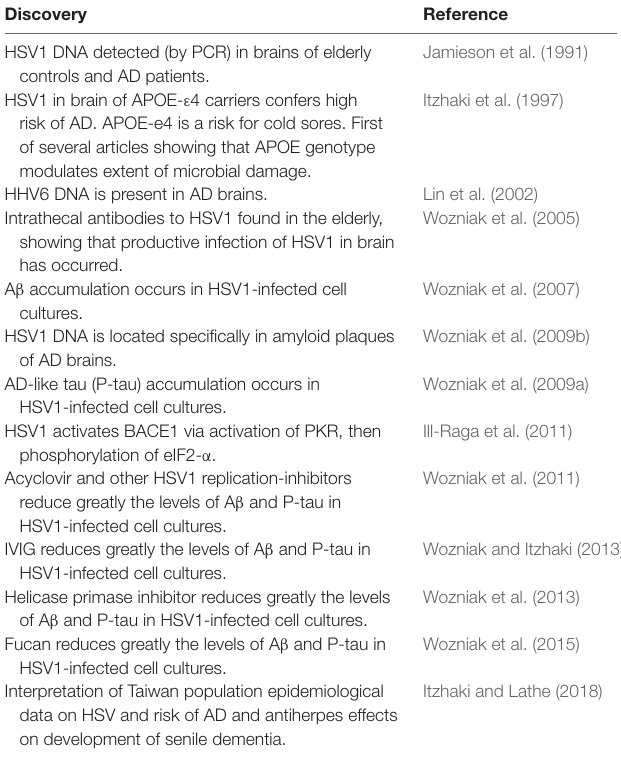
TABLE 1 | Main data on herpes simplex virus type 1 (HSV1) and AD from the author’s laboratory between 1991 and